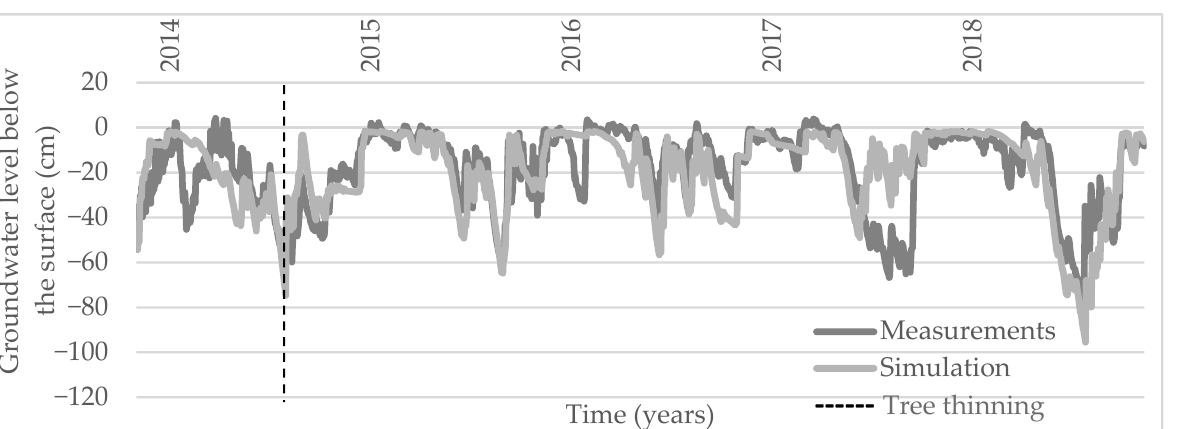
Table 2. Parameters that indicate the accuracy of the simulation model by study plots.